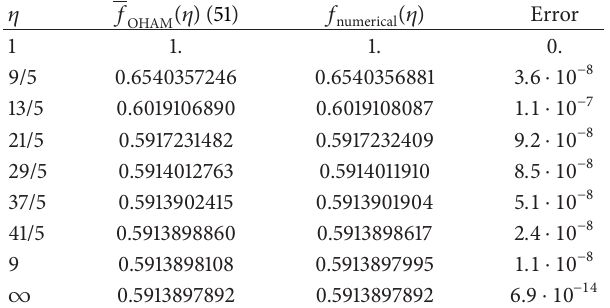
Table 9: Comparison between the derivative 𝑓 (𝜂) − (52) and numerical results for 𝛾 = 1 and 𝑆 = −2 (error = | 𝑓 OHAM (𝜂)| ). 𝑓 󸀠 numerical